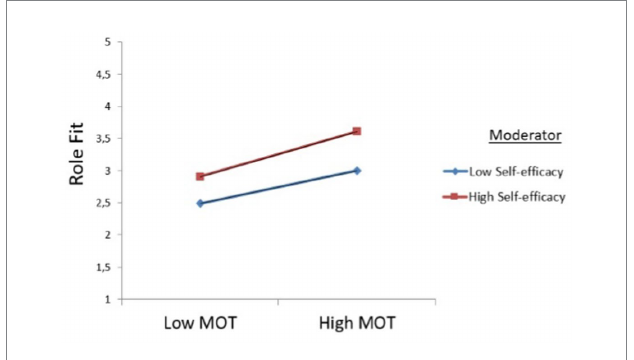
FIGURE 3 Graphical visualization of interactive effects for prosocial motivation (MOT) and self-efficacy (SEL) on role fit (RLF) at the beginning of military training